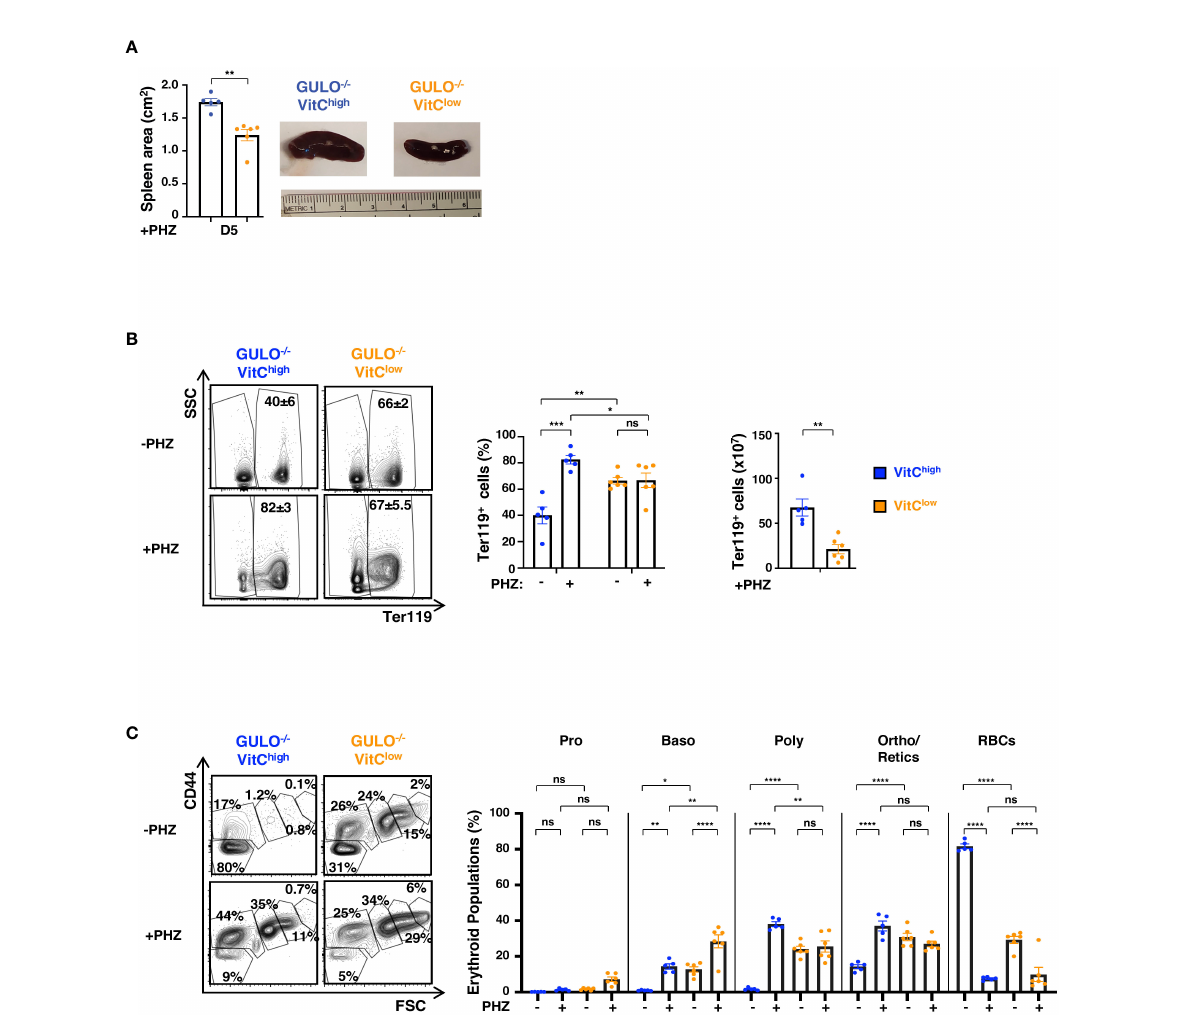
FIGURE 8 Impaired stress erythropoiesis in ascorbate-de fi cient GULO -/- mice in response to acute hemolytic anemia. (A) Spleen area (cm 2 ) in PHZ-treated GULO -/- mice was measured at day 5 and means ± SEM (left) as well as representative images (right) are shown. (B) The impact of PHZ-induced hemolytic anemia on the percentages and absolute numbers of splenic Ter119 + cells in GULO -/- VitC high and GULO -/- VitC low mice are shown at day 5. Representative Ter119/SSC contour plots, percentages, and absolute numbers of Ter119 + cells are presented (n=5-6 mice per group). (C) Changes in splenic proerythroblast, basophilic, polychromatic, orthochromatic erythroblast, and reticulocyte subsets as well as RBCs were monitored in PHZ-treated GULO -/- VitC high and GULO -/- VitC low mice as described in (Figure 7F). Quanti fi cations of erythroid precursors as well as representative CD44/FSC contour plots are shown. Statistical analyses were performed using an unpaired two-tailed t-test in panels (A, B) and a two-way ANOVA (Tukey ’ s test) in panel (C) . *p < 0.05; **p < 0.01; ***p < 0.001; ****p < 0.0001; ns, not signi fi